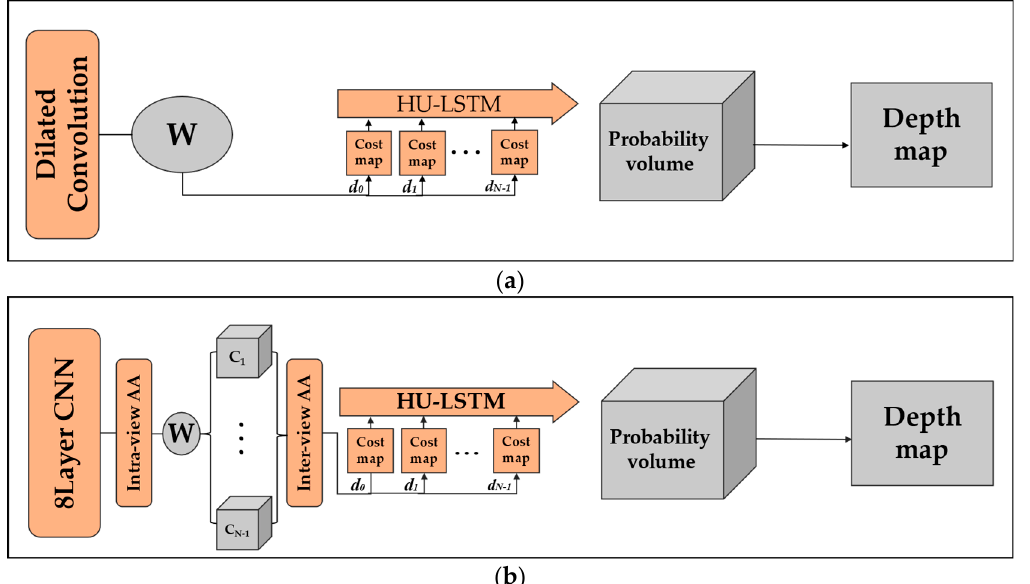
Figure 7. Schematic diagram of various deep learning MVS networks. ( a ) D 2 HC-MVSNet; ( b ) AA-